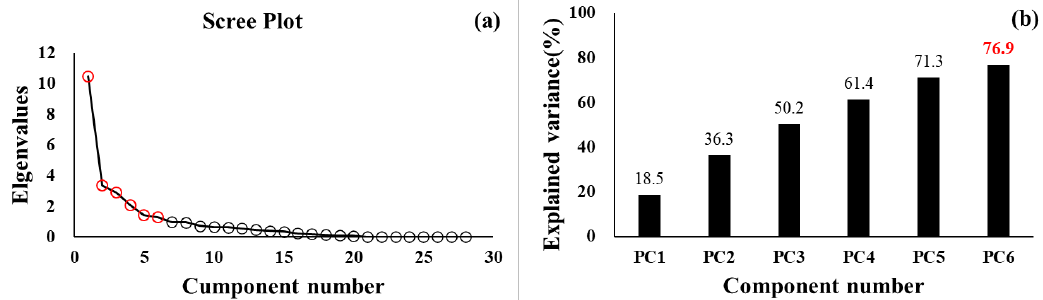
Figure 2. Principle component analysis (PCA) outcomes. ( a ) Cumulative percentage of the total variance (76.9%) explained by the principal components (PC s ). ( b ) Scree plot of the 28 principal